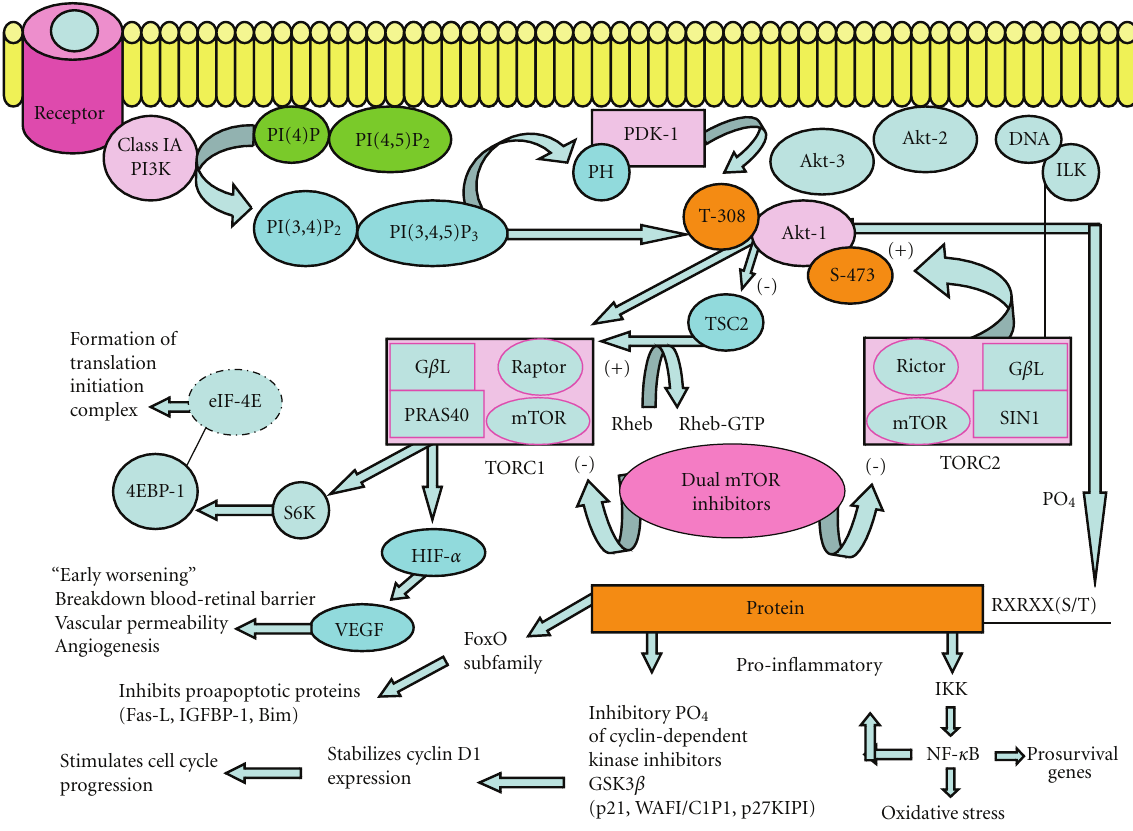
Figure 1: Schematic of the PI3K/Akt/mTOR Pathway. pathway highlights downstream e ff ectors pertinent to the development of diabetic retinopathy along with the benefit of dual inhibitors of mTOR (TORC1 and TORC2) that prevent feedback activation and prevent downstream e ff ectors that are detrimental in the progression of diabetic retinopathy. References consulted for Figure 1: [56], Paloma Pharmaceuticals presentation files, and Angioceutics